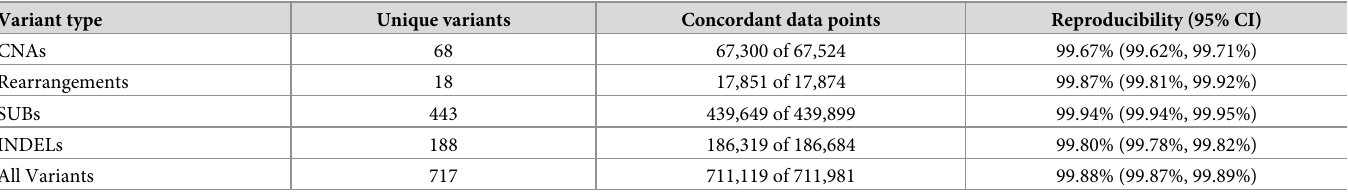
Table 9. Reproducibility of platform-wide variant detection.